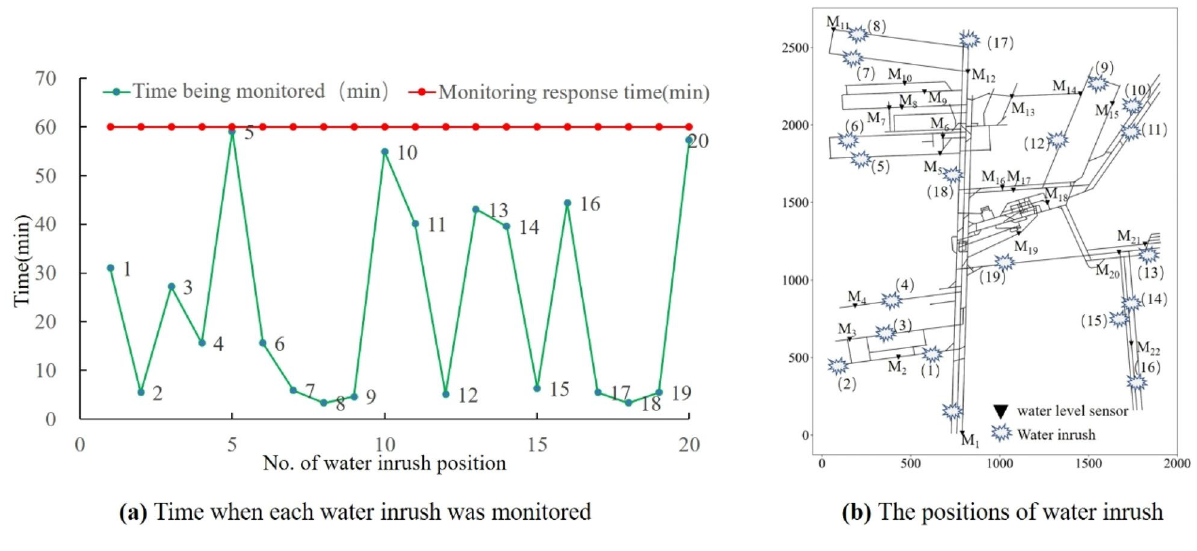
Figure 16. Reliability verification of the monitoring response